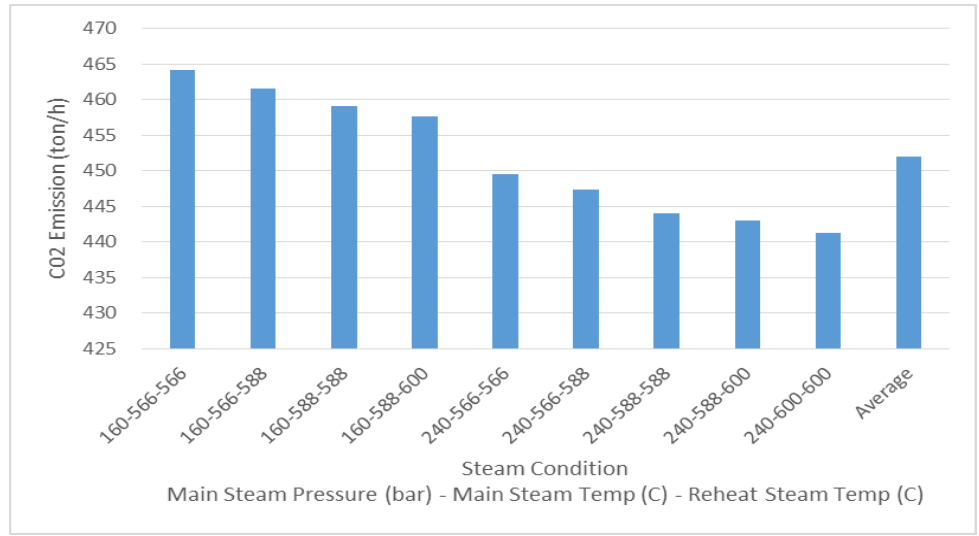
Figure 9. CO 2 emissions by steam conditions.